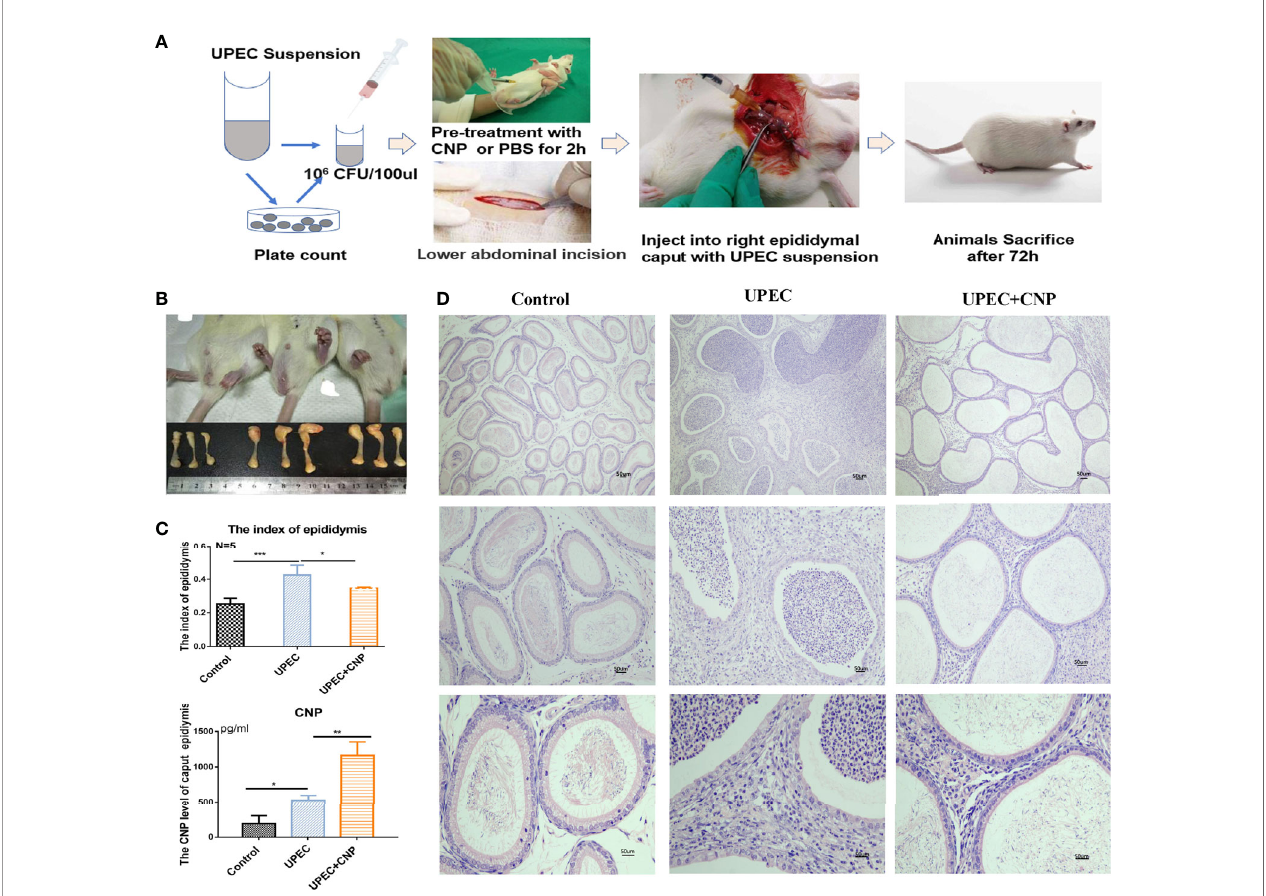
FIGURE 1 | Morphological traits of acute caput epididymitis in rats. (A) Steps to establish the model of epididymitis. (B) Visual changes of caput epididymitis and rat epididymal index. (C) The CNP content of caput epididymal fl uid was determined by ELISA. (D) H&E staining showed the characteristics of rat caput epididymitis under a microscope. Bar = 50 um. The data shown are representative of multiple experiments (mean ± SD, n = 5, *P < 0.05, **P < 0.01, ***P <